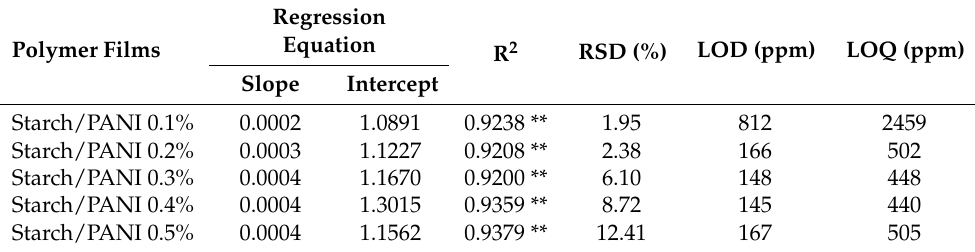
Figure 11. The colourimetric response of starch/PANI (0.1, 0.2, 0.3, 0.4, 0.5%) films against ammonia solution with varied concentration from 200 ppm to 1000 ppm. Table 4. Regression equation, correlation coefficient (R 2 ), relative standard deviation (RSD), limit of detection (LOD), and limit of quantification (LOQ) of the analysis of starch/PANI (0.1, 0.2, 0.3, 0.4, 0.5%) films as ammonia sensor.